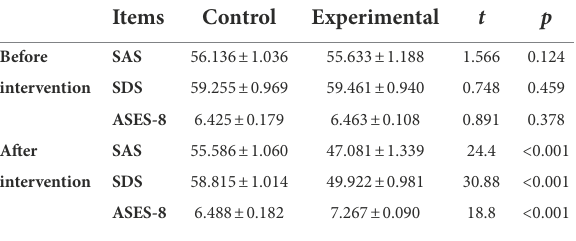
and after routine nursing intervention (6.488 ± 0.182; the last time;